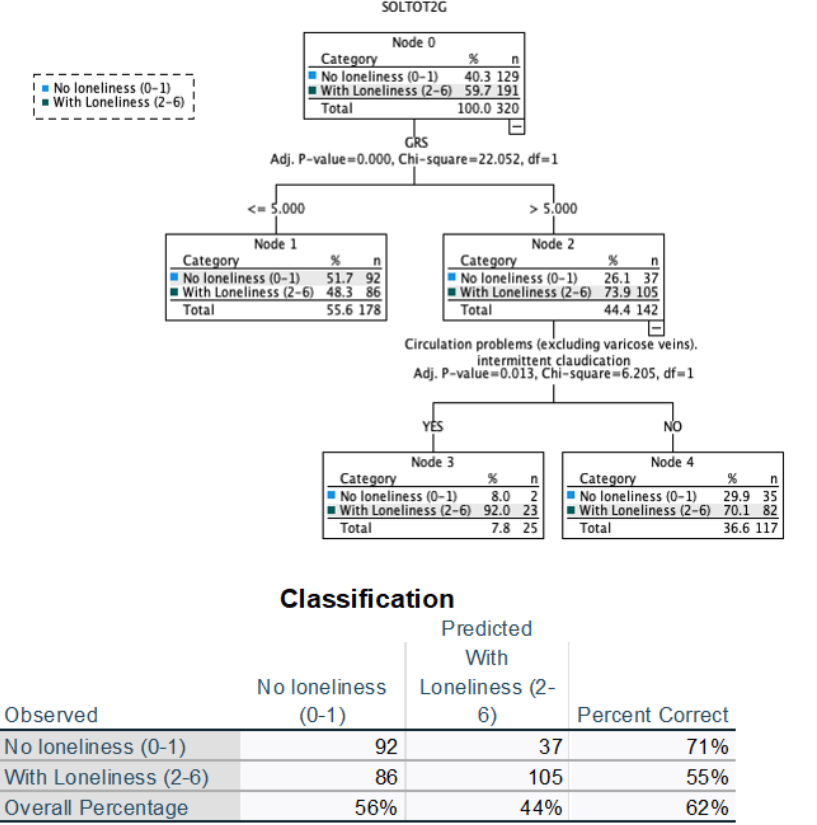
Figure 2. Decision tree and table of classification of objective variables related to health.